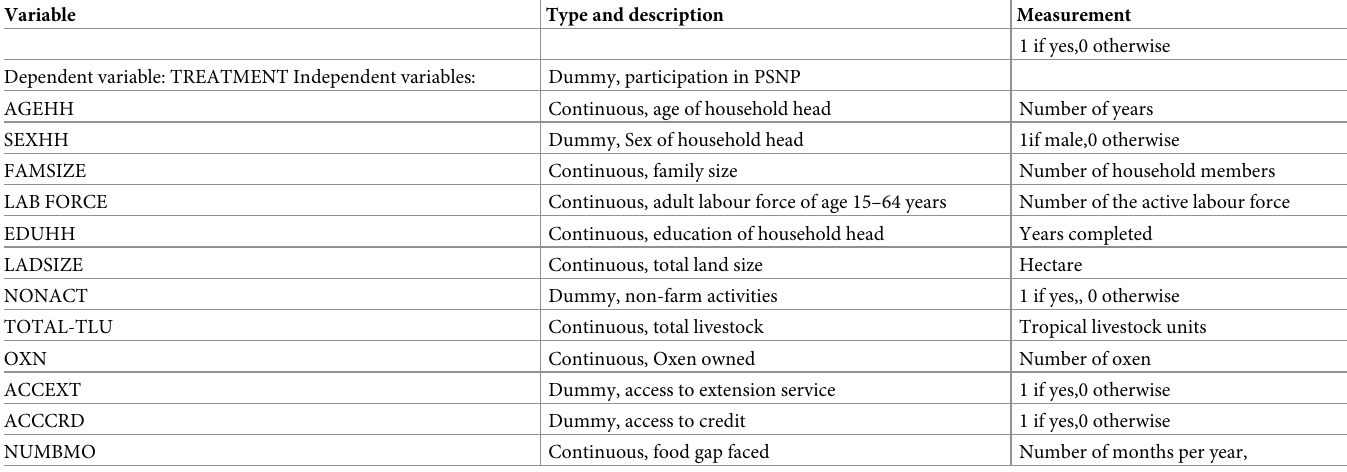
Table 1. Variable description and